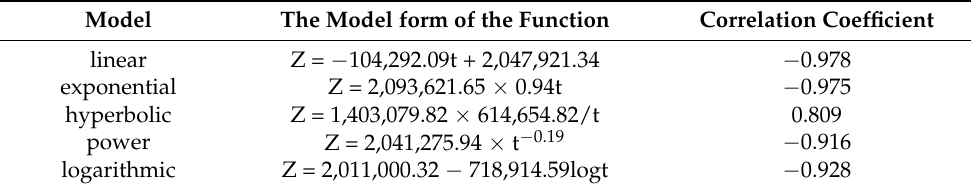
Table 9. A summary of the regression analysis results for the domestic coal sales (“Export 7”).